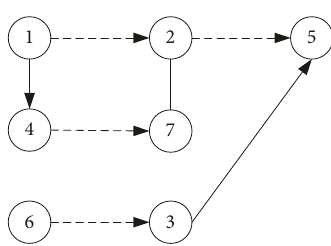
Figure 9: Topological diagram for the scheduling of block trans- portation tasks ( 𝑛 =7).